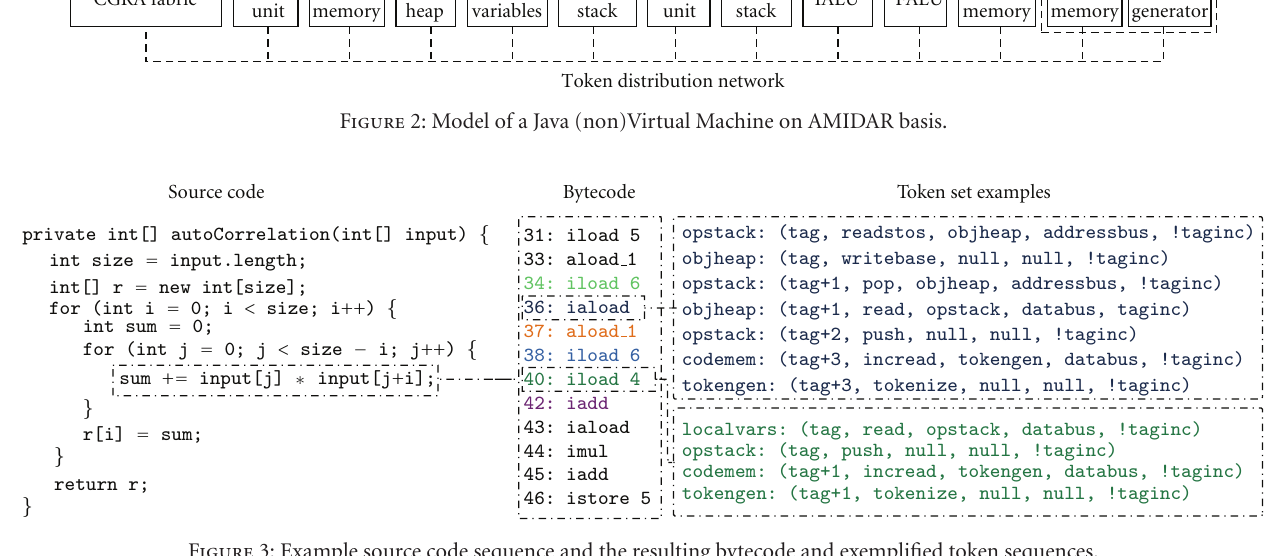
Figure 3: Example source code sequence and the resulting bytecode and exemplified token